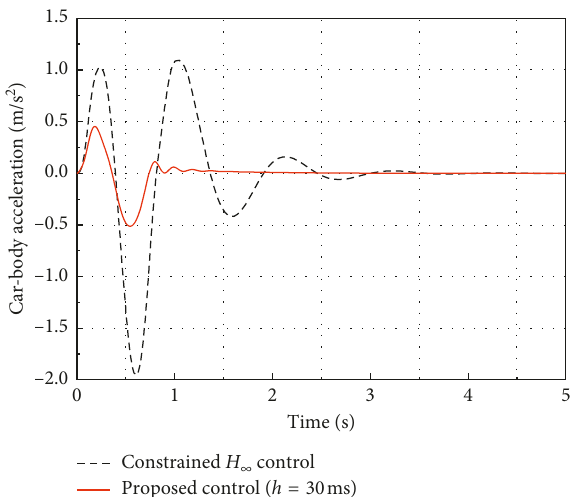
Figure 5: Car-body acceleration results under the shock road